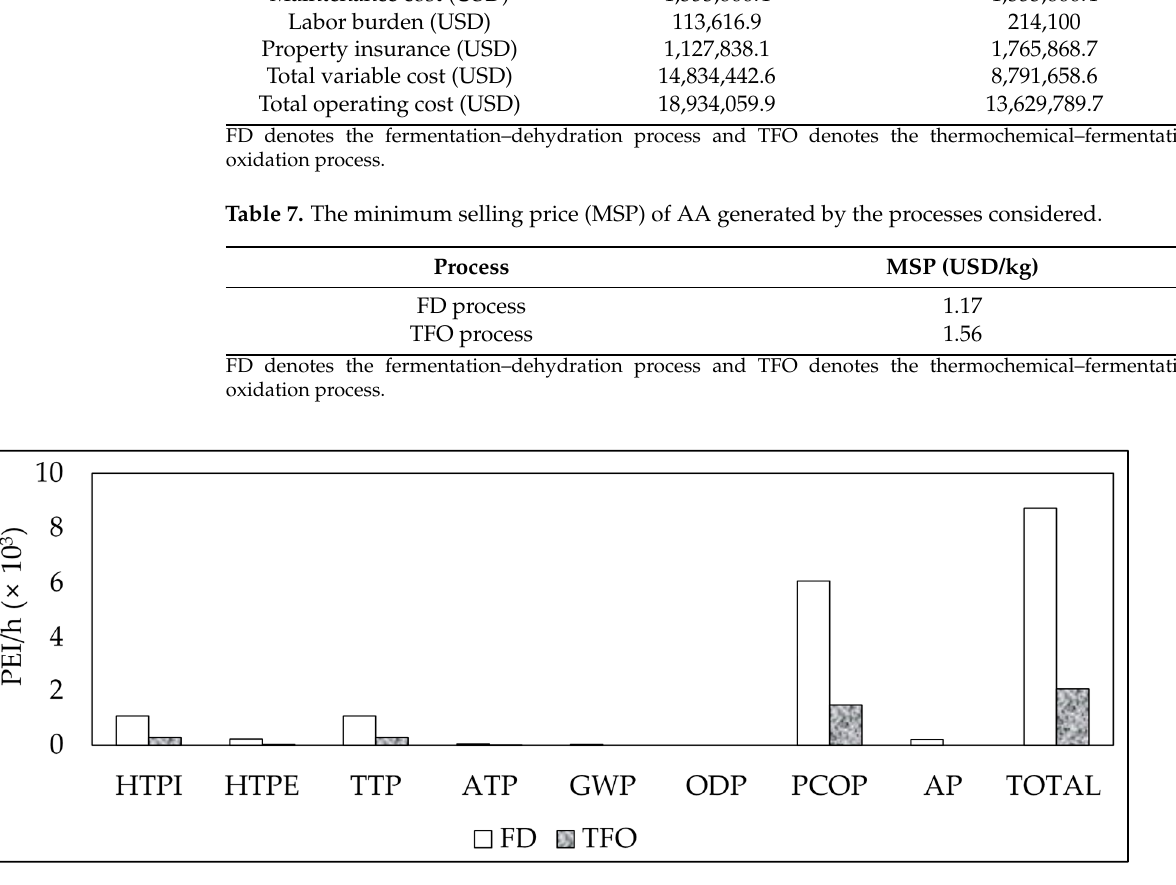
Figure 5. Potential environmental impacts per h for the fermentation–dehydration (FD) and